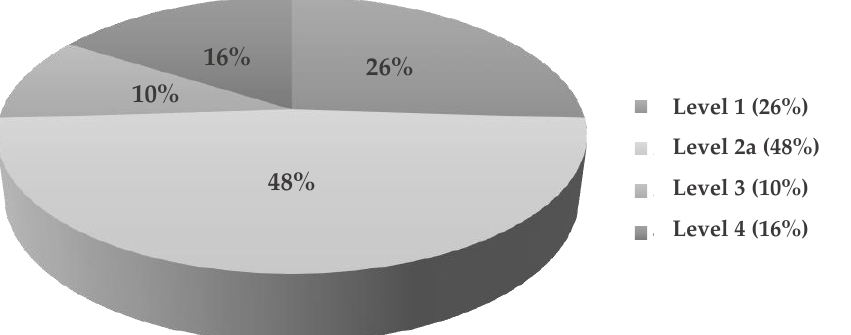
Figure 3. Distribution of the identification confidence levels of the xenobiotics by suspect screening.